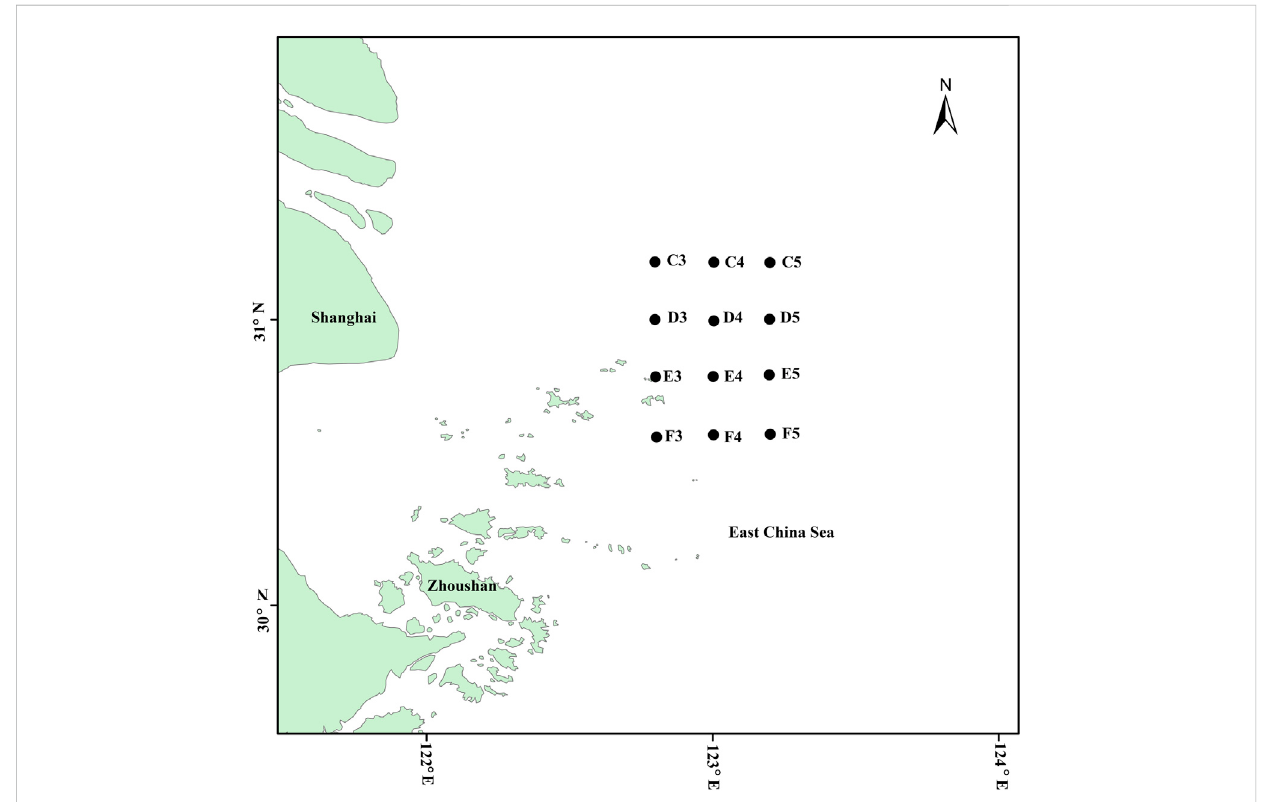
FIGURE 1 Map of the sampling sites in the Changjiang